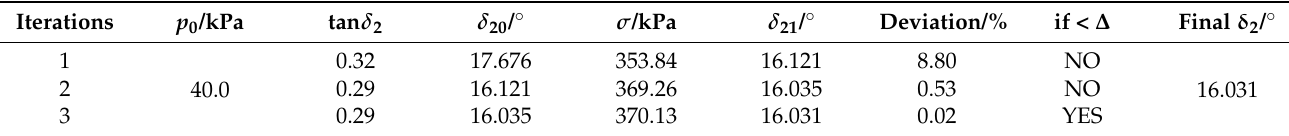
Table 4. Calculation process of δ 2